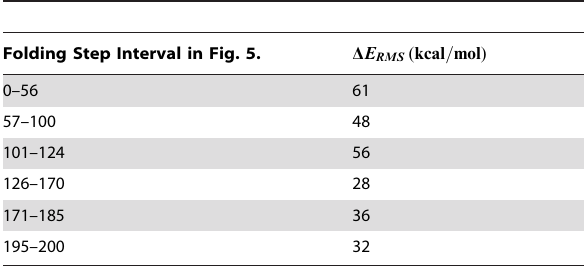
Table 2. The internal energy fluctuations along the folding trajectory.